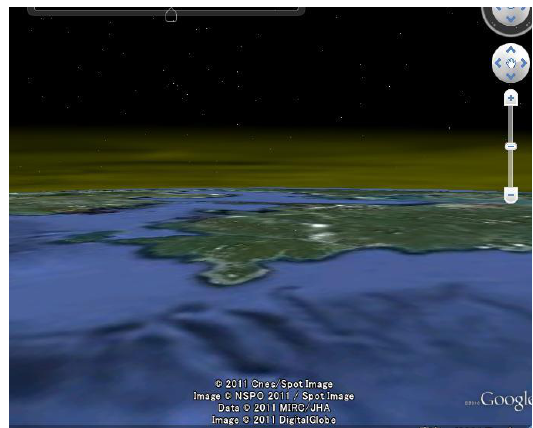
Fig.8 Asian dust cloud at 10:00 on March 20, 2010 when we looked at the Google Earth in the transverse direction.